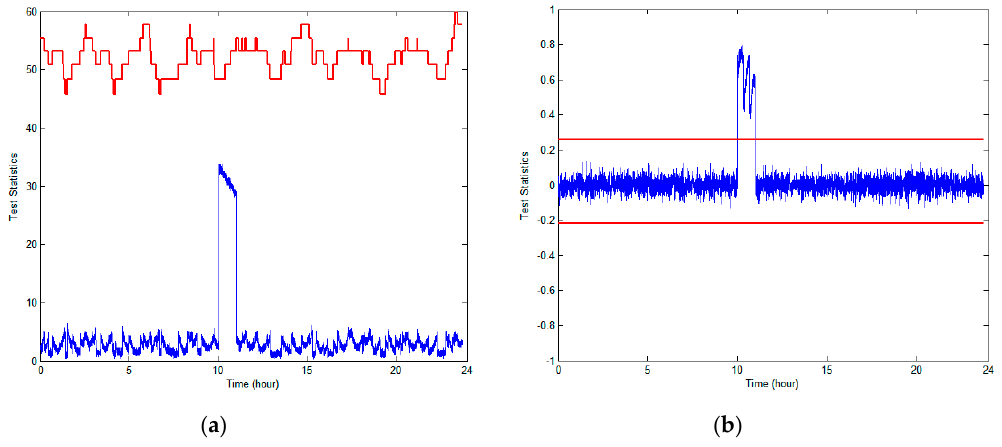
Figure 6. Performance comparison of anomaly detection schemes when a +100-m bias was injected into the observed PRN9 from the GPS synthetic data: ( a ) receiver autonomous integrity monitor (RAIM) and ( b ) RAIM/TDNN.